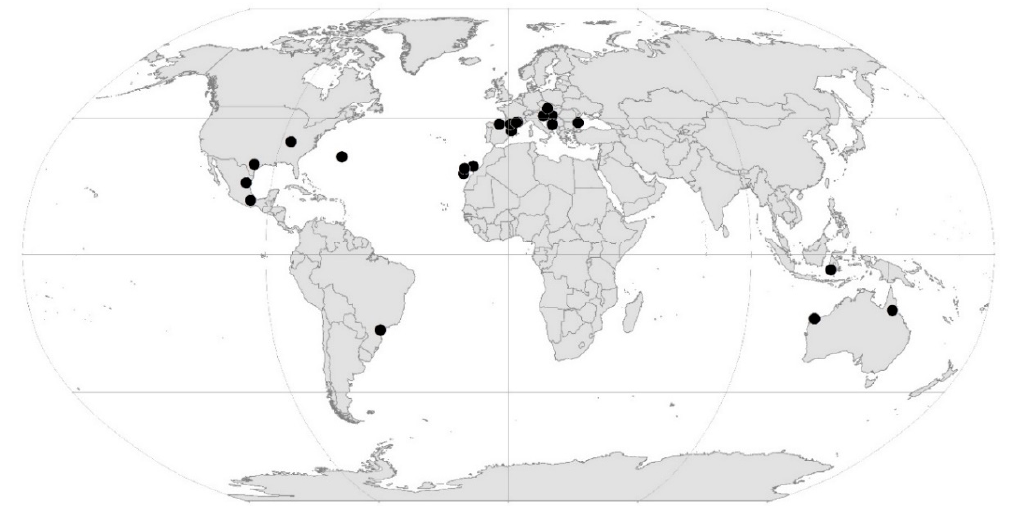
Figure 1. Map of hotspot sites listed in Table 1. Map prepared by Magda Aljanˇciˇc, used with permission. Table 1. All sites with 25 or more stygobionts plus troglobionts. Caves assessed in this special issue are marked with an asterisk. Stygo- Troglo- No. Unde- Terrain and Hydro- Rank Rank Total Rank bionts bionts scribed geology